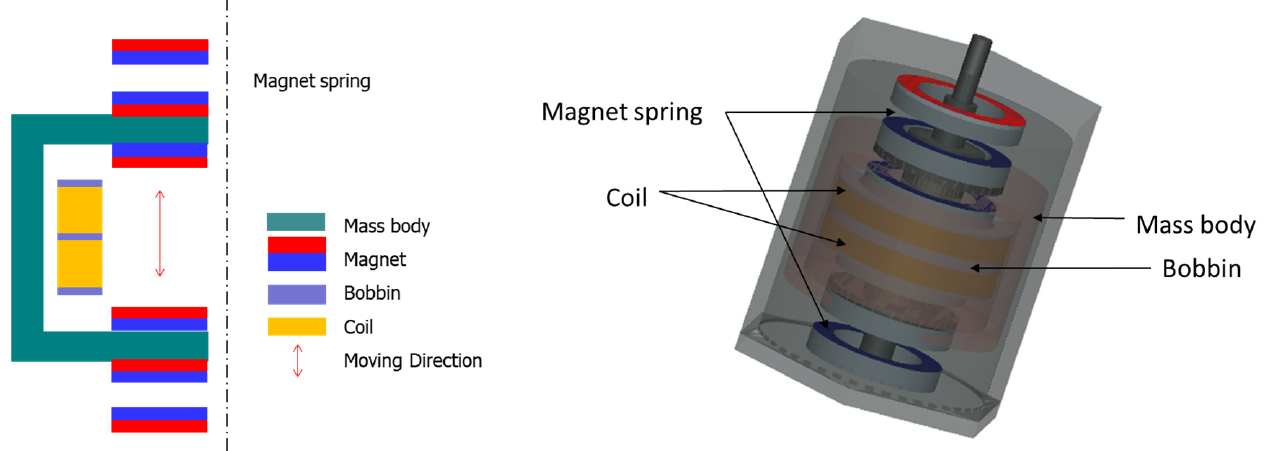
Figure 8. Schematic structure of magnetic spring vibration ‐ energy ‐ harvesting device. The magnetic spring was composed of a pair of Nd magnets at the top and bottom,